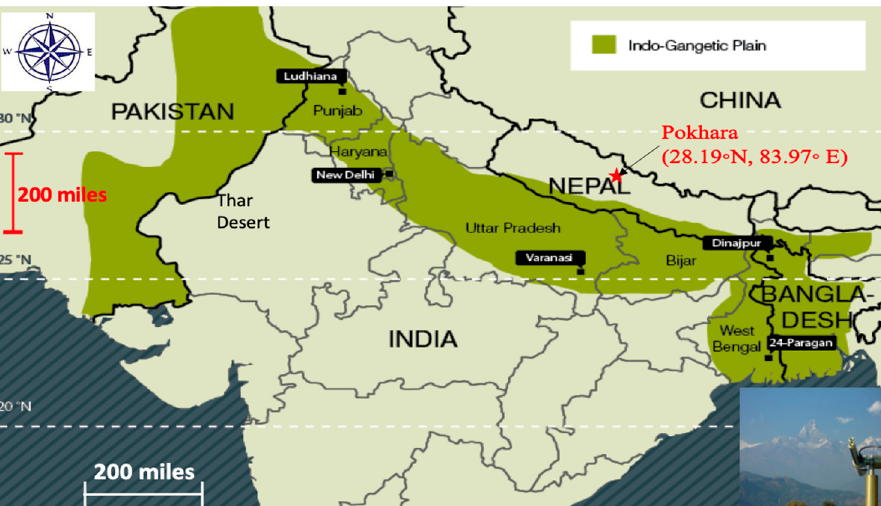
Figure 1. The map with the aerosol ground monitoring station (Pokhara, Nepal) has an inset in the bottom right corner that shows the Aerosol Robotic Network (AERONET) sun photometer in Pokhara (photo by Arnico Panday) and a compass rose on the left corner. This image is adopted from online resources, and horizontal and vertical scales in 200 miles are shown on the map.